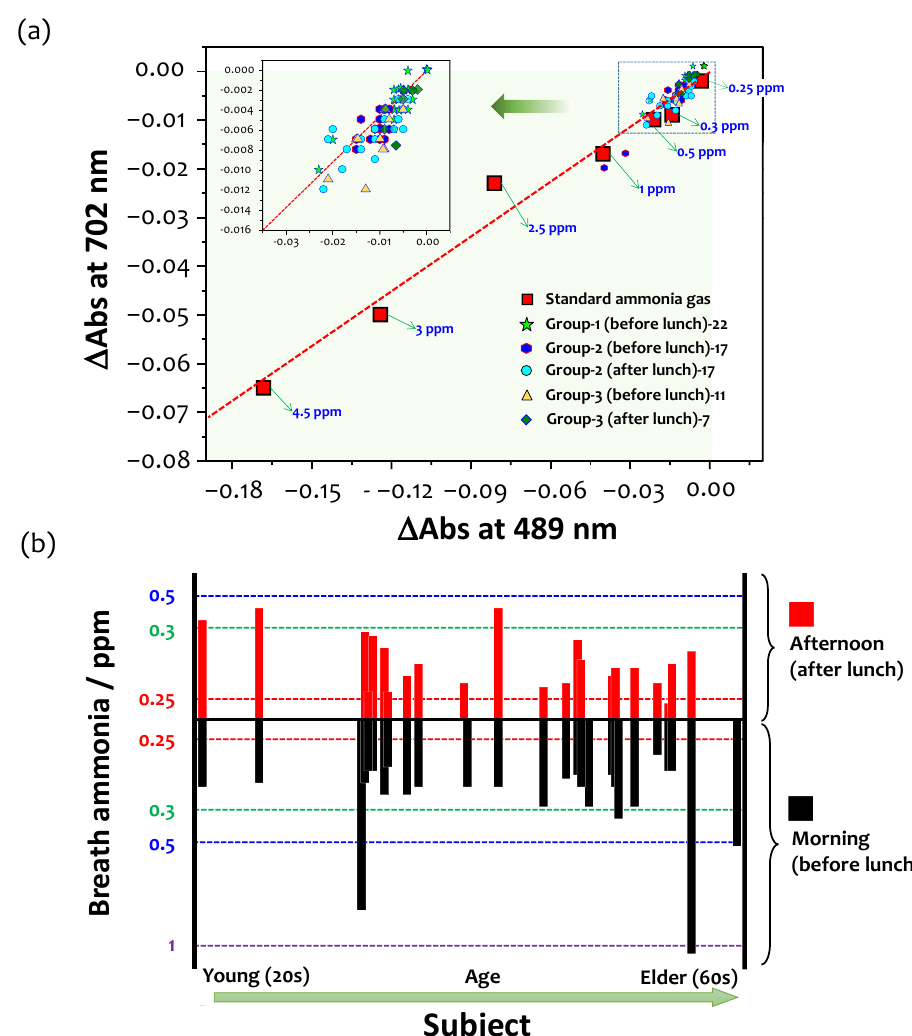
Figure 9. ( a ) A linear correlation between both characteristic peaks of the respective Soret and Q bands at 489 and 702 nm, respectively, including 84 breath samples collected from the 41 healthy subjects before and after food consumption. ( b ) A comparison of breath ammonia concentrations before and after food consumption for 26 and 22 healthy subjects, respectively, where the Y-axis was estimated from the sum of the absorbance changes at 489 and 702 nm.